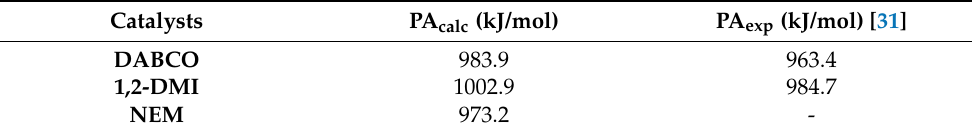
Table 3. Computed (PA calc ) and measured proton affinities (PA exp ) of the tertiary amines of the studied catalysts: 1,4-diazabicyclo[2.2.2]octane (DABCO), 1,2-dimethylimidazole (1,2-DMI), and N-ethylmorpholine (NEM), in kJ/mol. The calculations were carried using the